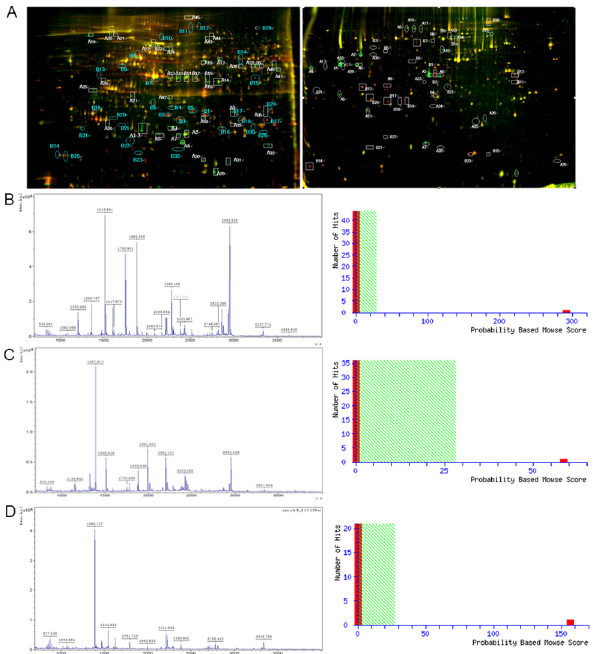
Fig 1. Representative 2D-DIGE, PMF and Mascot score maps of L428 cells and A20 cells. ( A ) Left panel: Protein spots expressed differentially between L428- CD99 cells and L428-CTR cells were marked on the maps and further identified by MALDI-TOF MS. Right panel: Protein spots expressed differentially between A20-m CD99 L2- cells and A20-CTR cells were marked on the maps and further identified by MALDI-TOF MS. ( B ) Left panel: MALDI-TOF mass spectrum of spot B15 obtained from L428 cells (spot B15 corresponds to SEPTIN2 ) after trypsin digestion. Right panel: The Mascot score of spot B15 confirmed by MALDI-TOF MS was 292 . ( C ) Left panel: MALDI-TOF mass spectrum of spot A8 obtained from A20 cells (spot A8 corresponds to SEPTIN2 ) after trypsin digestion. Right panel: The Mascot score of spot A8 confirmed by MALDI-TOF MS was 58. ( D ) Left panel: MALDI-TOF mass spectrum of spot A28 obtained from A20 cells (spot A28 corresponds to STATHMIN ) after trypsin digestion. Right panel: The Mascot score of spot A28 confirmed by MALDI-TOF MS was